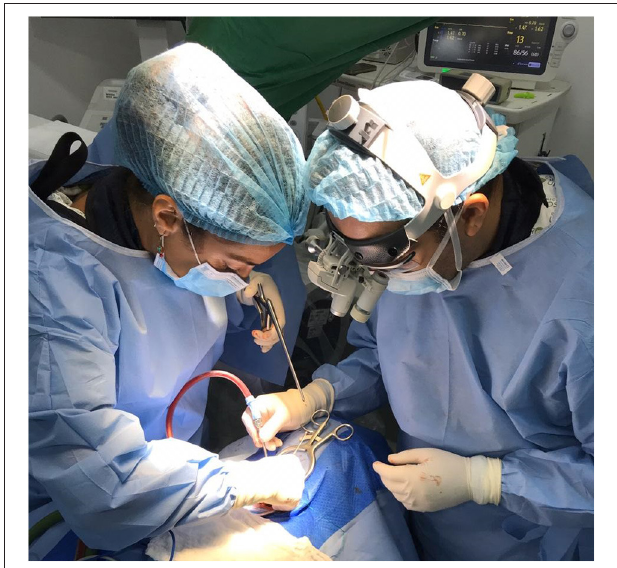
FIGURE 1 | Dr. Laura Pastor, visiting neurosurgical resident from Spain, performing a spinal cord injury surgery with a mentor of the fellowship program in Colombia, Dr. Alvaro Soto.